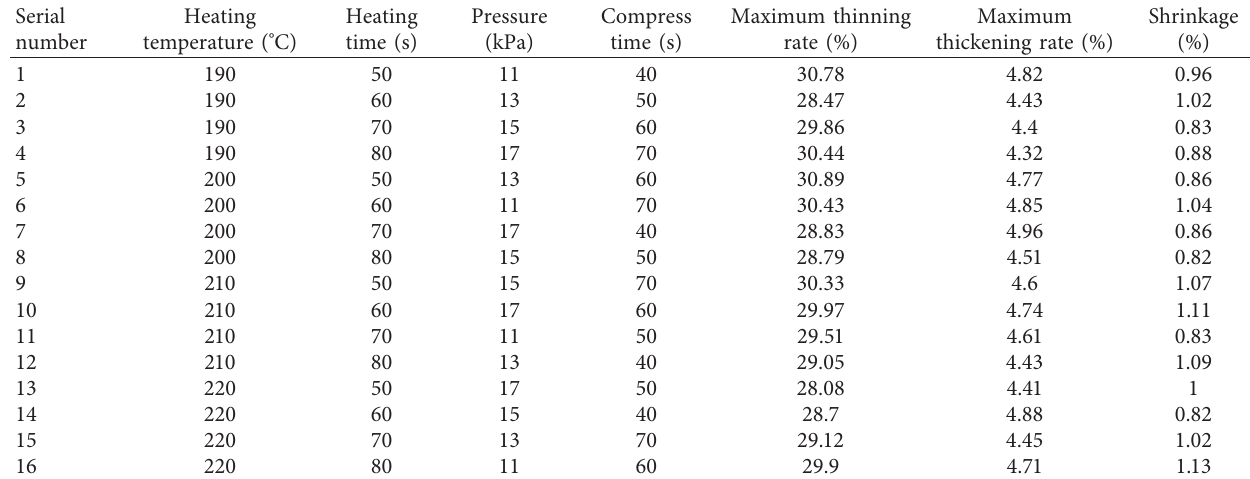
Table 2: Results of orthogonal experiments.